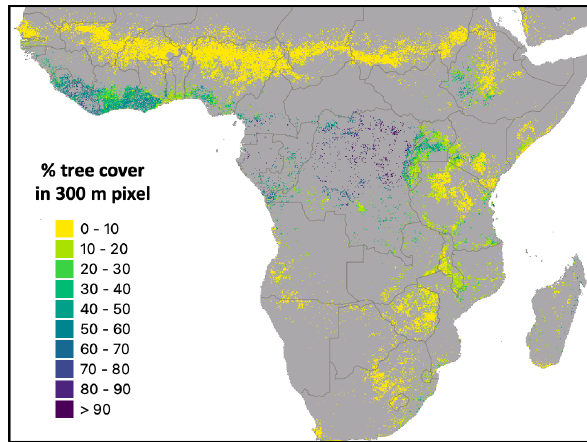
Figure A1. Distribution of tree cover percentage in rain-fed cropland-class pixels in Africa. Grey pixels belong to other classes.